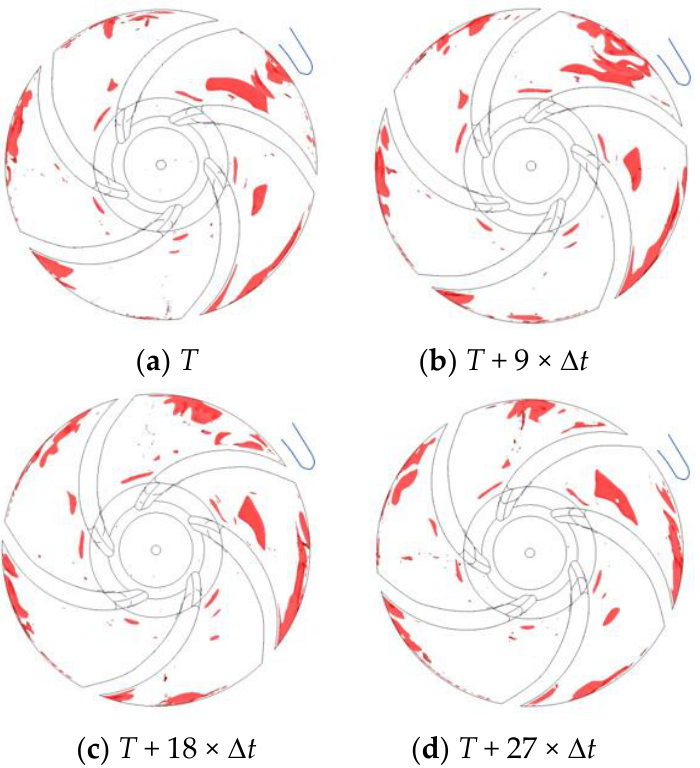
Figure 18. Distribution of the K for one pump cycle at different times ( Q = 1.0 × Q , K max = 30). At the times of T , T + 9 × ∆ t and T + 18 × ∆ t , the regions with K max agreed fairly